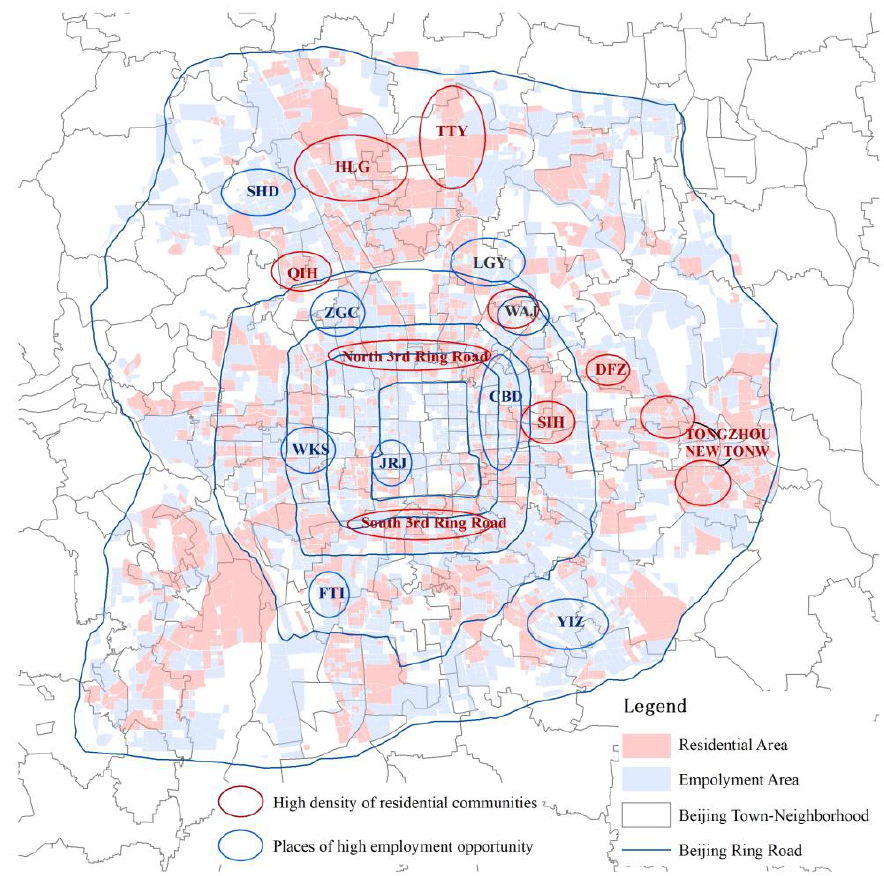
Figure 2. Distribution of residential and employment areas within the sixth ring road of Beijing. The main high density residential and employment areas are marked and circled with red and bluelines.